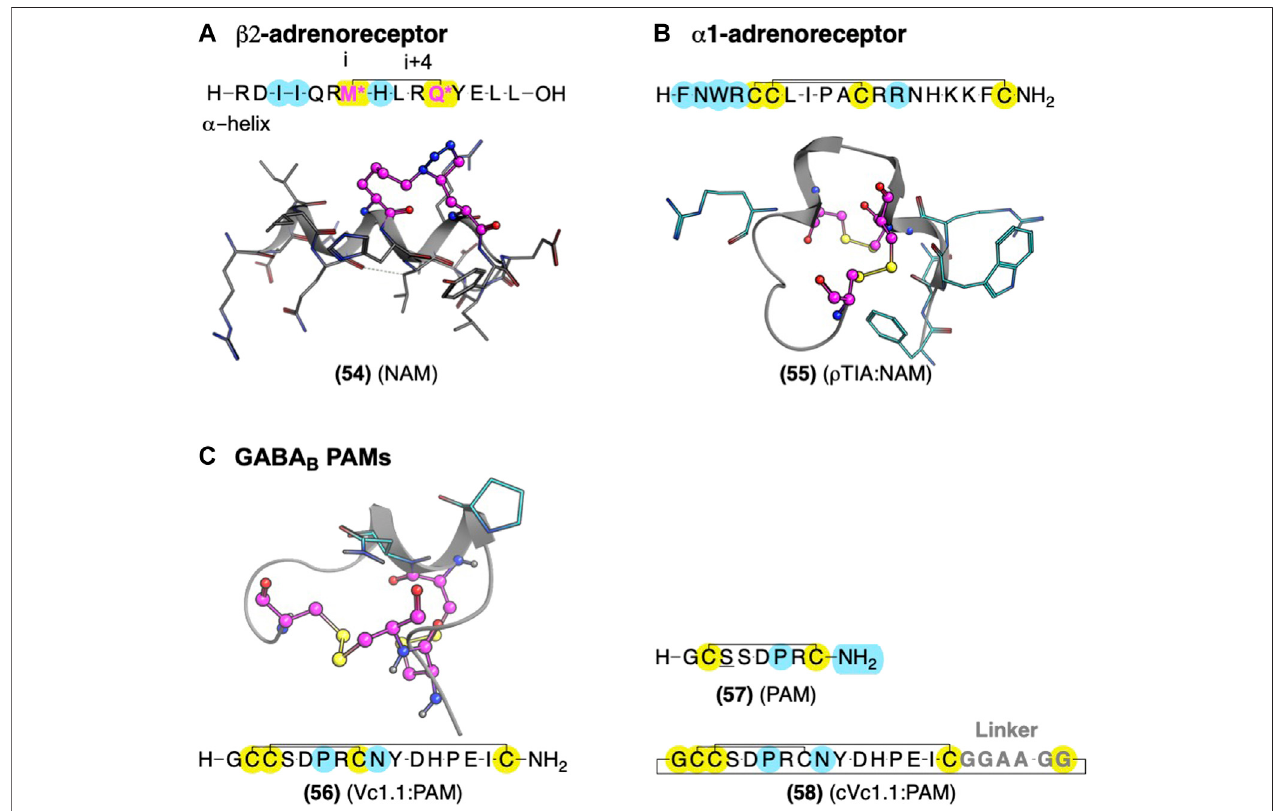
FIGURE 12 | Global conformational restraints to stabilize secondary structures with AMs identi fi ed from G α s and conotoxins. (A) Model of stapled peptides from G α s to stabilize α helix based on the crystal structure (PDB Code: 3SN6) (Rasmussen et al., 2011). (B) Conotoxin AMs ρ TIA at the α 1-adrenoreceptor and α -conotoxin Vc1.1 attheGABA B stabilizedbydisul fi debonds — NMRstructures ρ TIANMR(PDBCode:2LR9)(Ragnarssonetal.,2013)and (C) NMRstructureofVc1.1(PDBCode: 2H8S) (Clark et al., 2006). Yellow highlights residues involved in macrocyclization. * (pink letters) indicate side chains replaced with an alkyne and azide group to mediate “ stapling. ”